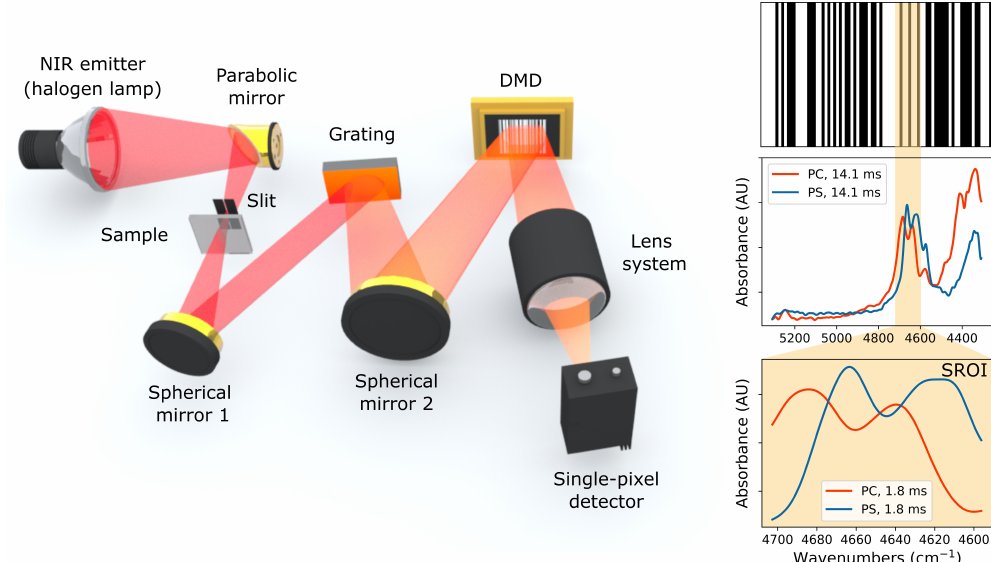
Figure 1. Schematic optical arrangement and principles of operation of the developed dispersive multiplex spectrometer. Thermal emitter radiation (halogen lamp) passes the slit, which determines the optical throughput and the resolution of the system (i.e., spatial size of a single spectral element in the DMD plane); spherical mirror 1 collimates the light and redirects it to the diffraction grating, spherical mirror 2 focuses the spectral components onto the DMD producing an image of the spectrum; the modulated radiation is collected by the lens system and focused onto a single point detector. The inset plots indicate the absorbance spectra (AU, absorbance units) of polystyrene (PS) and polycarbonate (PC) that are encoded by barcode-like modulation patterns. SROI can be obtained by using only a fraction of the modulation